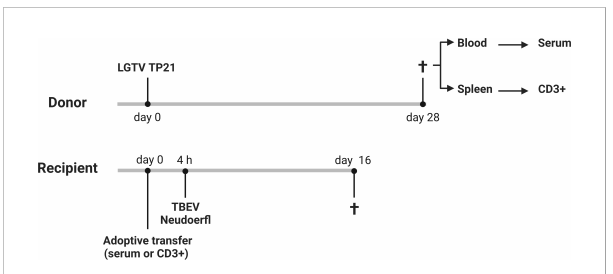
FIGURE 3 Schematic representation of adoptive transfer experiments. 6-8 weeks old control or LGTV infected donor mice (n=5) were sacri fi ced at 28 dpi and the sera and spleens were collected. 200 µl of pooled serum or 2.53x10 7 CD3 + T cells from control or LGTV infected mice were administered i.p. into 10-12 weeks old naïve recipient mice (n=5). After 4 h, these mice were challenged with TBEV Neudoer fl (created with BioRender.com).